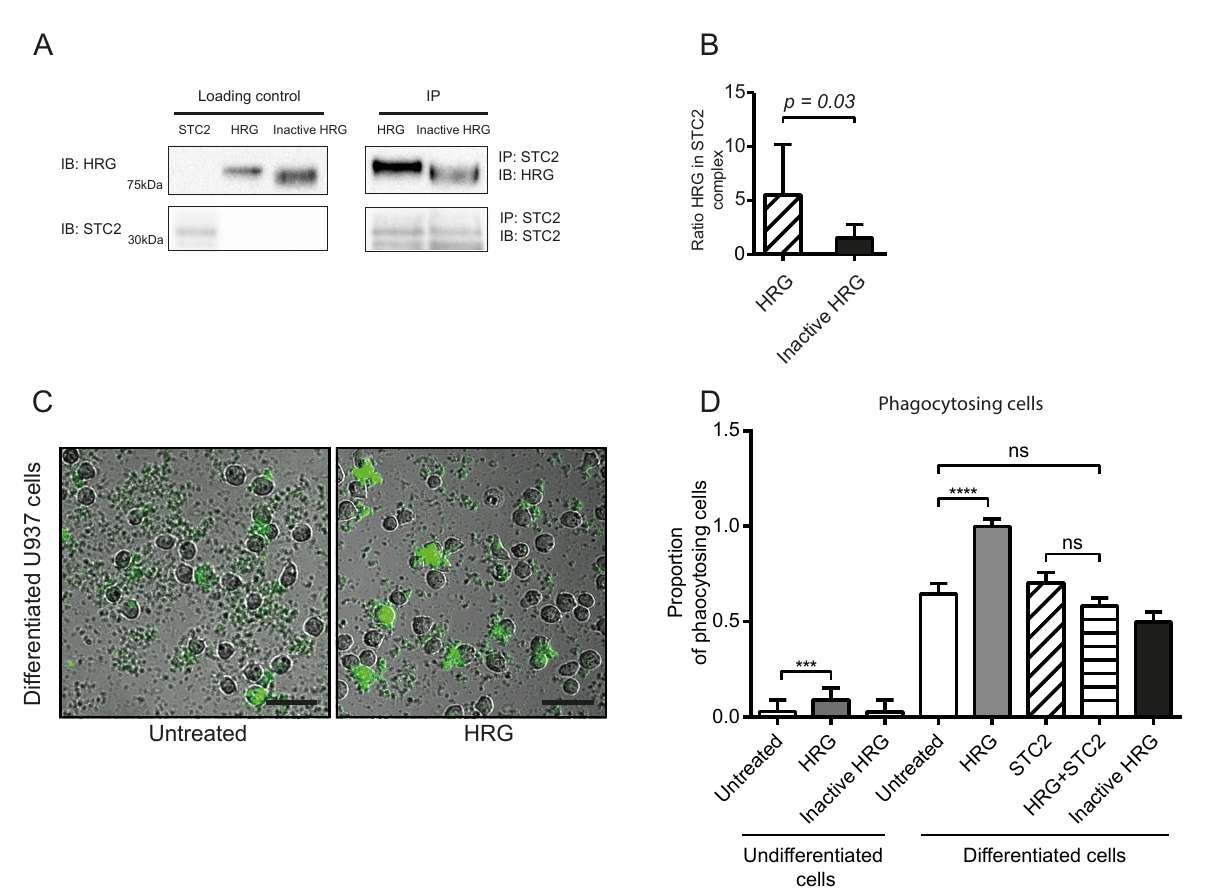
Figure 1. Recombinant HRG binds STC2 and modulates phagocytosis of bioparticles. ( A ) Co- immunoprecipitation of HRG but not inactive HRG with STC2. Recombinant proteins (2 µ g each) were separated on SDS-PAGE as individual preparations (loading control) or after mixing and im- munoprecipitation (IP) using antibodies against STC2, followed by immunoblotting (IB) as indicated. ( B ) Ratio of HRG (active or inactive) band intensities in the STC2 immunoprecipitate normalized to corresponding active and inactive HRG loading controls. Statistical analysis; Student’s t -test. ( C ) Representative microscope images of U937 monocytes without (left) or with treatment with active HRG (right) in the phagocytosis assay. Green cells have engulfed pH-sensitive fluorescent bioparticles. Scale bar; 50 µ m. ( D ) Quantification of phagocytosis efficiency in the different treatment conditions. The proportion of positive (green) phagocytotic U937 cells to all cells per field of vision is shown in relation to the positive cells/total cells in the vitD3 differentiated HRG-treated condition (set to 1). Statistical analysis; Tukey’s multiple comparisons test ( D ). *** p < 0.001; **** p <